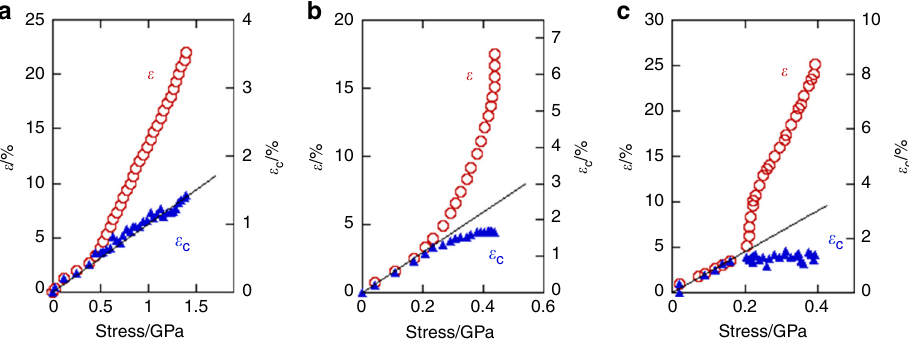
Fig. 5 Relationships between crystal strain and tensile stress in different kinds of silk. The changes in bulk strain ( ε ) and of crystal strain ( ε c ) against the tensile stress in the time-resolved simultaneous synchrotron X-ray analysis for a E . variegata bagworm silk, b B . mori ( Bombycidae ) silkworm silk, and c A . assama ( Saturniidae ) silkworm silk. The changes in tensile stress and crystal strain against the bulk strain, using the same experimental data, are shown in Supplementary Fig. 5